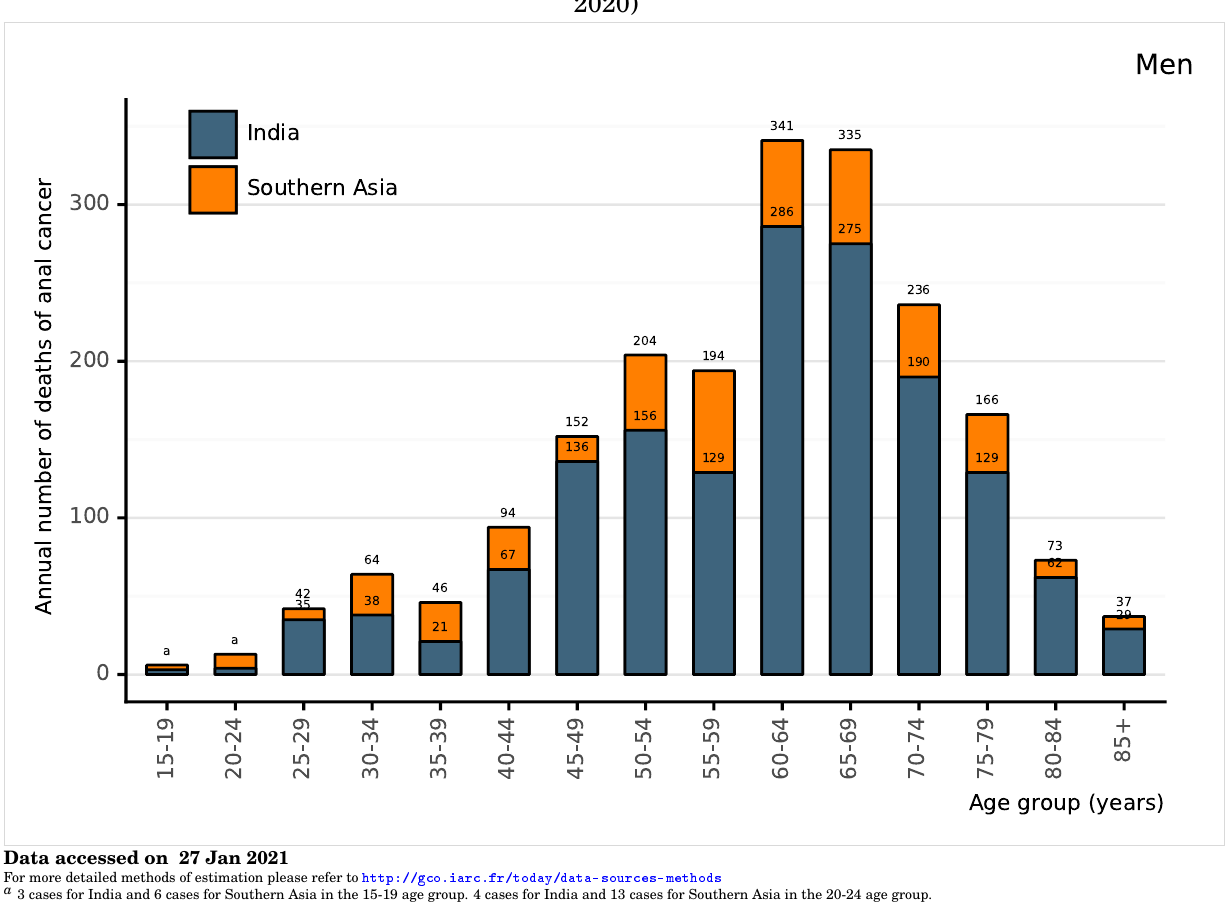
Figure 109: Annual number of deaths of anal cancer among men by age group in India (estimates